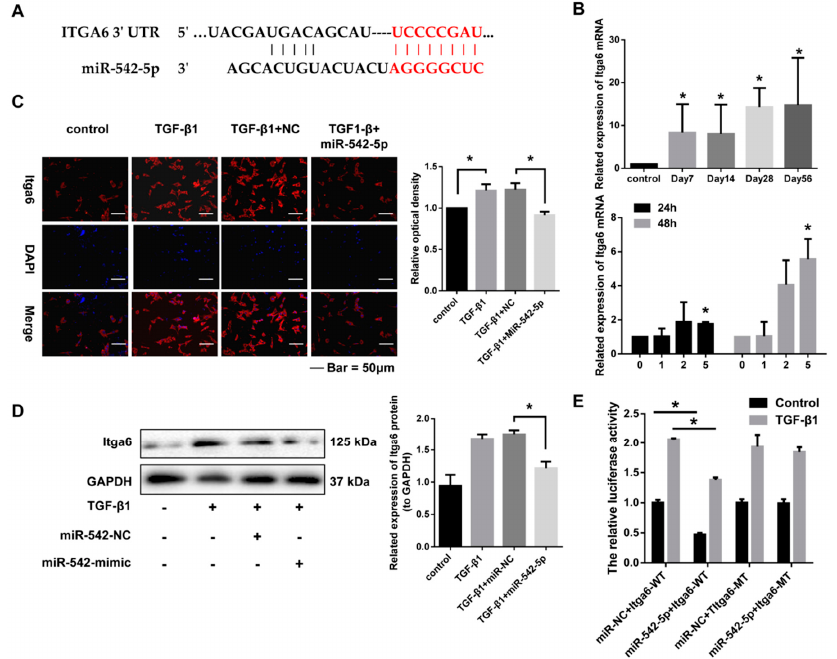
Figure 6. Integrin α 6 (Itga6) was a direct target of miR-542-5p. ( A ) Schematic outlining the predicted binding sites for miR-542-5p in the 3’-UTR of Itga6 mRNA. Red part represented the base-pairing of the seed sequence of miR-542-5p and the 3’UTR of Itga6. ( B ) The expression level of Itga6 mRNA was significantly increased in the lung tissues of mice treated with SiO2 on the seventh day, the 14th day, the 28th day and the 56th day and cells treated with different doses of TGF- β 1 (0, 1, 2, 5 ng/mL) at 24 h and 48 h, * p < 0.05 versus the control group. ( C ) The fluorescence intensity of Itga6 in NIH-3T3 cells co-treated with 5 ng/mL TGF- β 1 and 30 nM miR-542-5p mimic was notably lower than the cells treated with 5 ng/mL TGF- β 1; The ImageJ software was used for fluorescence quantification, * p < 0.05 was considered to be statistically significant. ( D ) The protein level of Itga6 in NIH-3T3 cells co-treated with 5 ng/mL TGF- β 1 and 30 nM miR-542-5p mimic was notably lower than the cells treated with 5 ng/mL TGF- β 1, * p < 0.05 versus the TGF- β 1 + mimic-NC group. ( E ) Effects of the miR-542-5p mimic on Itga6 3 (cid:48) -UTR luciferase reporters in NIH-3T3 cells. Luciferase activities were calculated as the ratio of firefly/Renilla activities and normalized to the miR-NC + Itga6 wild type (WT) group. * p < 0.05 was considered statistically